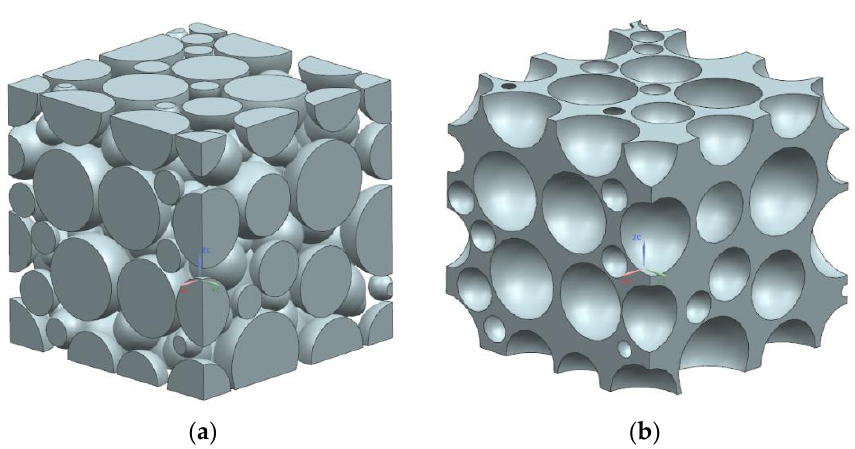
Figure 2. Operation in UG: ( a ) 3D pore solid model; ( b ) Metal-foam solid model.